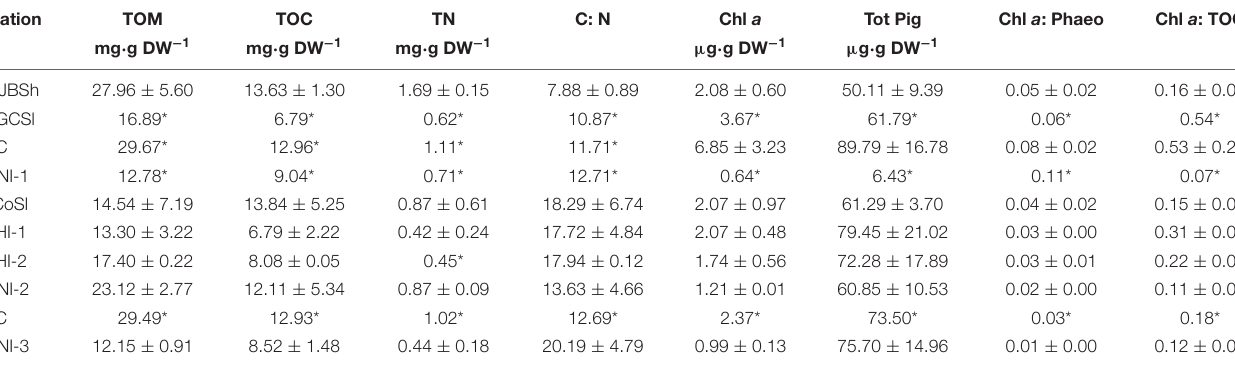
TABLE 4 | Summary of main organic matter quantity and quality parameters measured in the stations (average ± standard deviation derived from 2 or 3 replicate samples per station) *indicates values derived from only one replicate sample per station. Station TOM